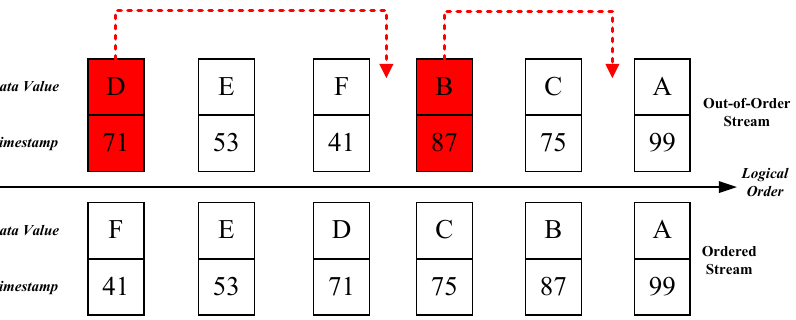
Figure 5. Graphic examples for Definitions 4 and